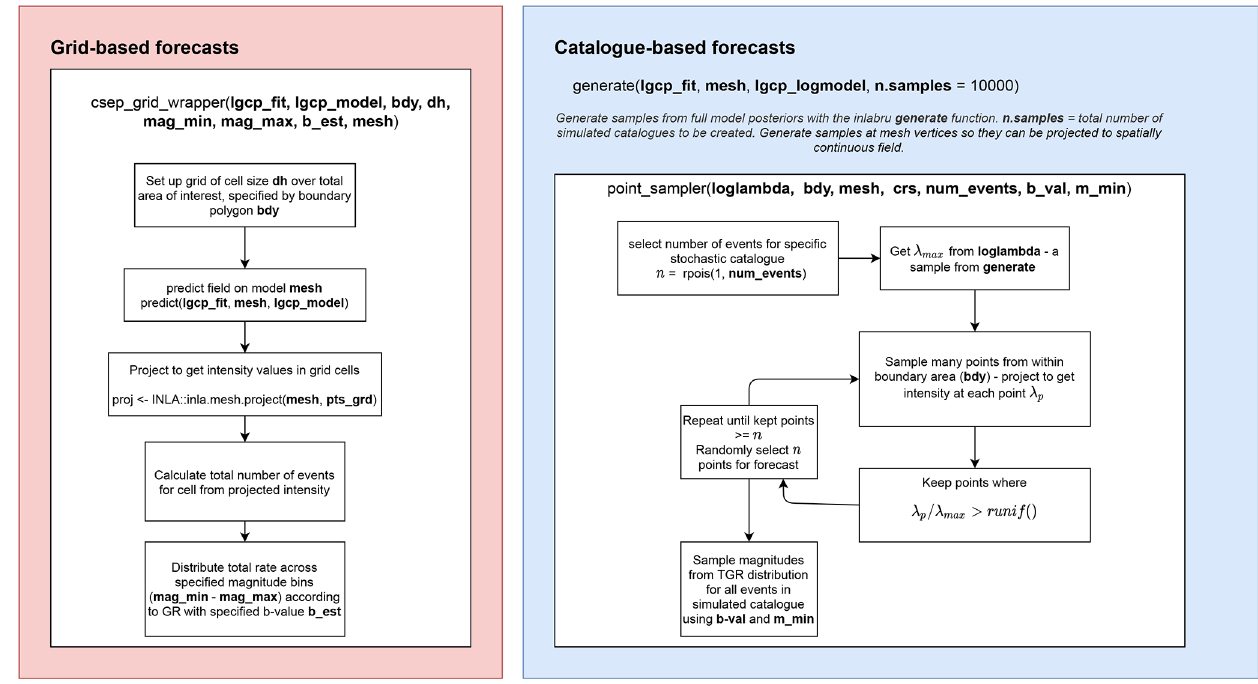
Figure 5. Schematic of the code for constructing grid-based (left) and simulated catalogue-based (right) earthquake forecasts given an inlabru LGCP intensity model. These represent step 7 of the